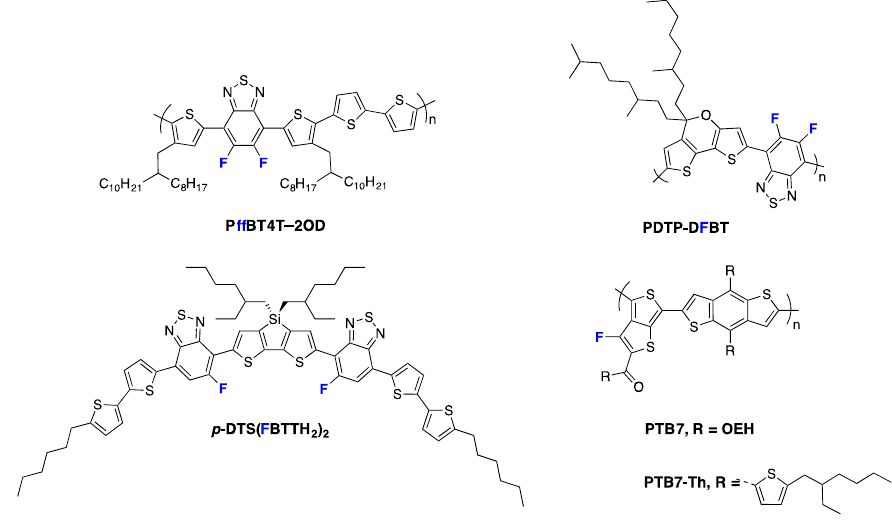
Figure 1. Chemical structures of highly efficient fluorinated materials for organic photovoltaics (OPV).